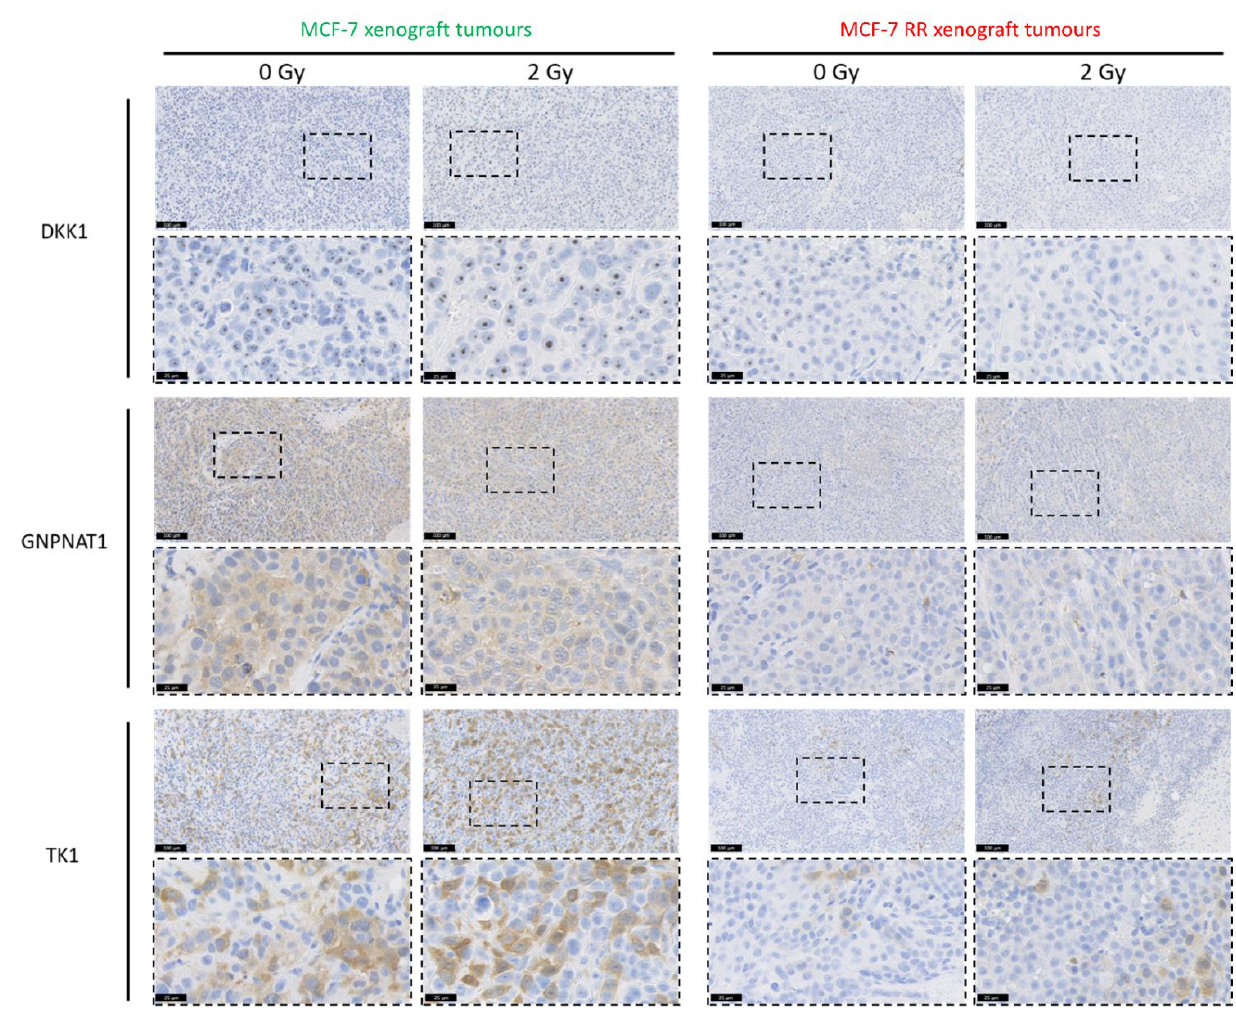
Figure 9. In vivo intracellular levels of lead candidate biomarkers. IHC assessing the intracellular levels of the lead candidate biomarkers in mouse xenograft tumours harvested 24 h after radiation. Representative images taken from five MCF-7 and five MCF-7 RR xenograft tumours.